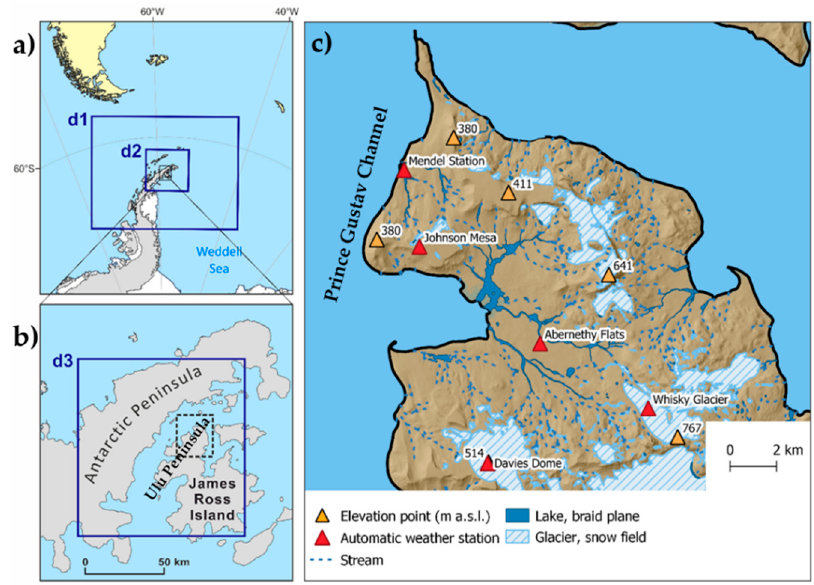
Figure 1. Study area location within the Antarctic Peninsula and position of the Weather Research and Forecasting model domains d1 and d2 ( a ); James Ross Island located in the neighborhood of the northeastern Antarctic Peninsula with the position of domain d3 and the northern part of the Ulu Peninsula (dashed) ( b ); northern part of the Ulu Peninsula with automatic weather stations mentioned in the text and selected elevation points ( c ). The map of the Ulu Peninsula is based on the topographic data of the Czech Geological Survey [49] and the Reference Elevation Model of Antarctica (REMA) [50].